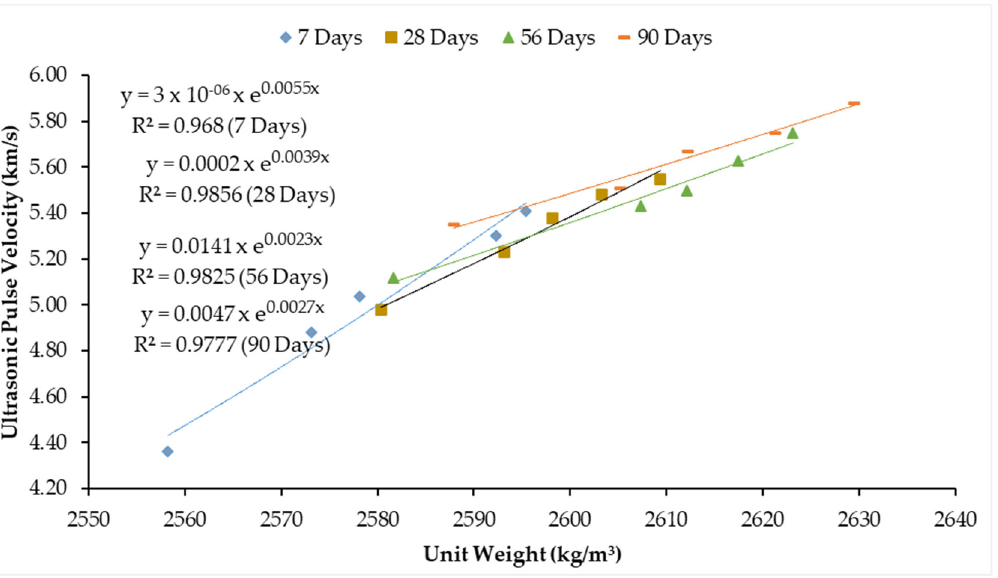
Figure 15. Relation between hardened density and UPV of concrete. Table 5. UPV of the WSA concrete and the concrete quality grading specified in